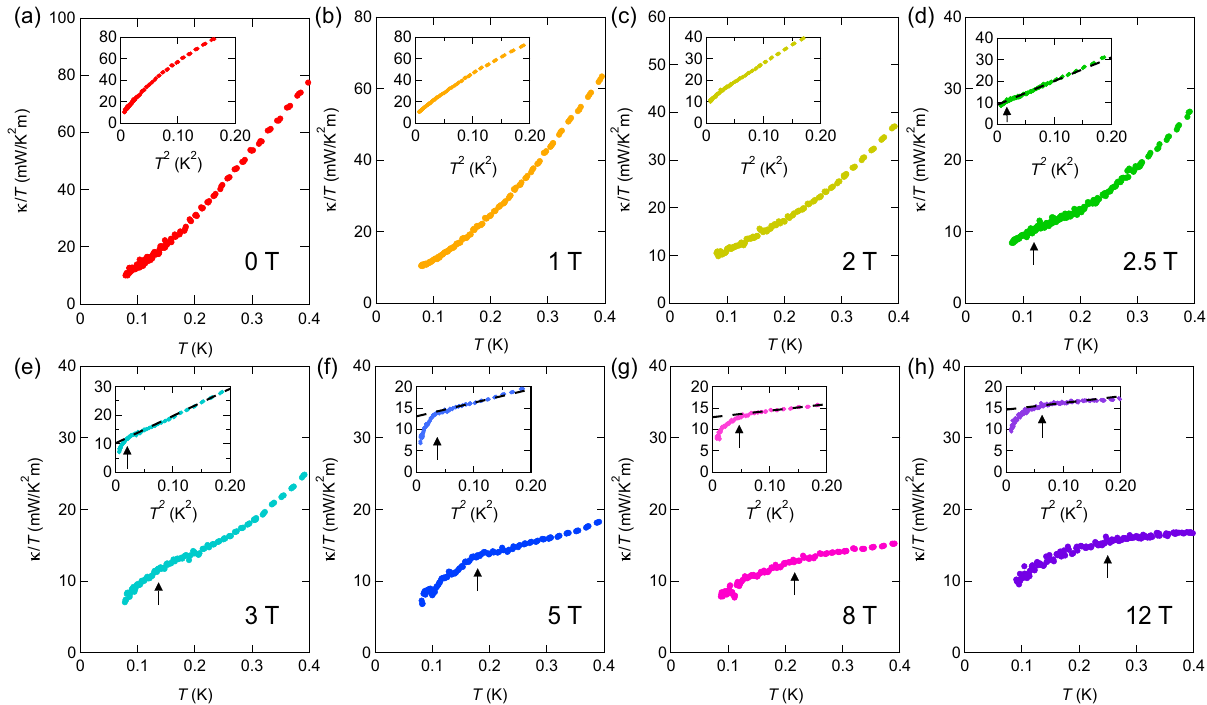
Fig. 8 Thermal conductivity of YbIr 3 Si 7 . a – h Thermal conductivity divided by temperature κ / T of crystal #1 plotted as a function of T in zero and magnetic fi eld for H ∥ c at very low temperatures. The insets show κ / T vs. T 2 . The dashed straight lines in ( d – h ) represent the linear extrapolation from the high- temperature regimes. Arrows in the main panels and insets indicate the temperatures at which κ / T deviates from the T 2